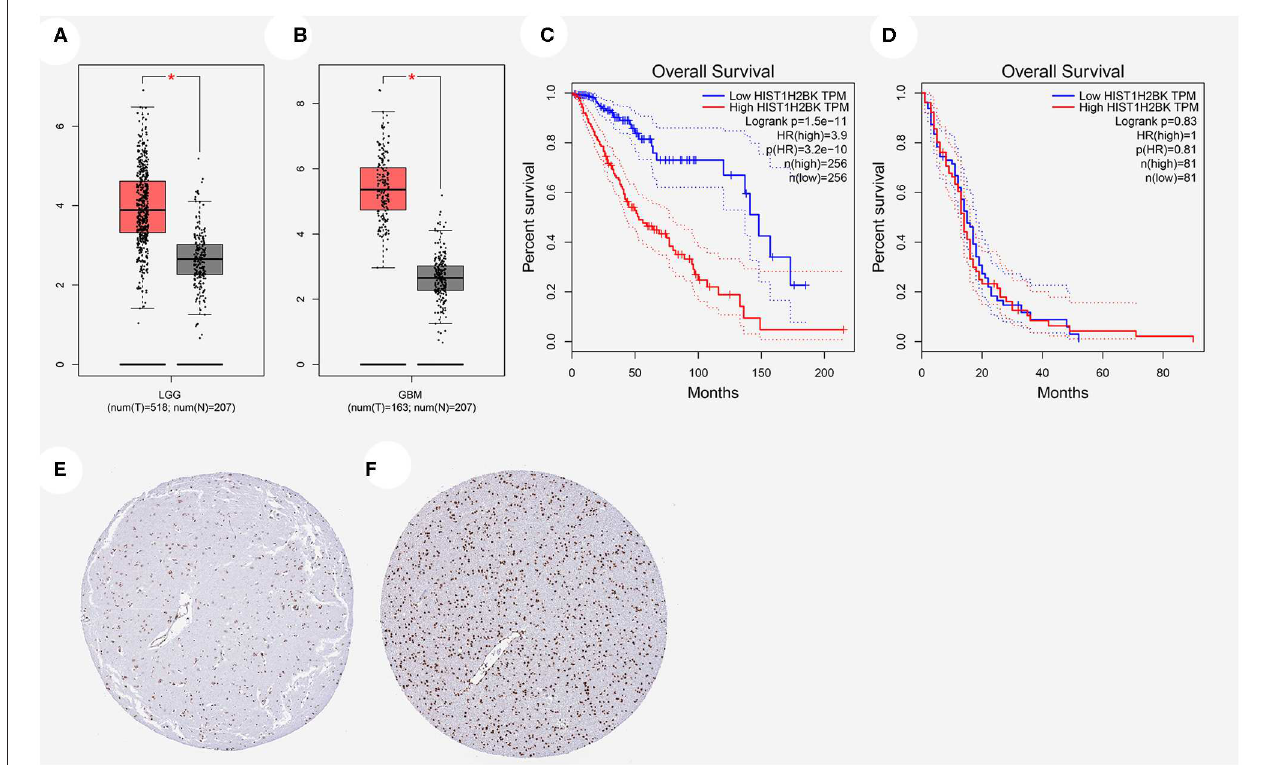
FIGURE 2 | Relationship between HIST1H2BK expression and prognosis of glioma patients based on GEPIA database and HPA database. (A) HIST1H2BK was significantly upregulated in LGG. * P < 0.05. (B) HIST1H2BK was significantly upregulated in GBM. * P < 0.05. (C) The relationship between HIST1H2BK expression levels and overall survival in LGG analyzed by GEPIA database. (D) The relationship between HIST1H2BK expression levels and overall survival in GBM analyzed by GEPIA database. (E) Protein levels of HIST1H2BK in normal tissue by immunohistochemistry based on the Human Protein Atlas (staining: medium; intensity: moderate; quantity: > 75%). (F) Protein levels of HIST1H2BK in LGG tissue by immunohistochemistry based on HPA (staining: high; intensity: strong; quantity: > 75%). GEPIA, Gene Expression Profiling Interactive Analysis; HPA, the Human Protein Atlas; LGG, low grade glioma; GBM, glioblastoma; num, number; T, tumor; N, normal.